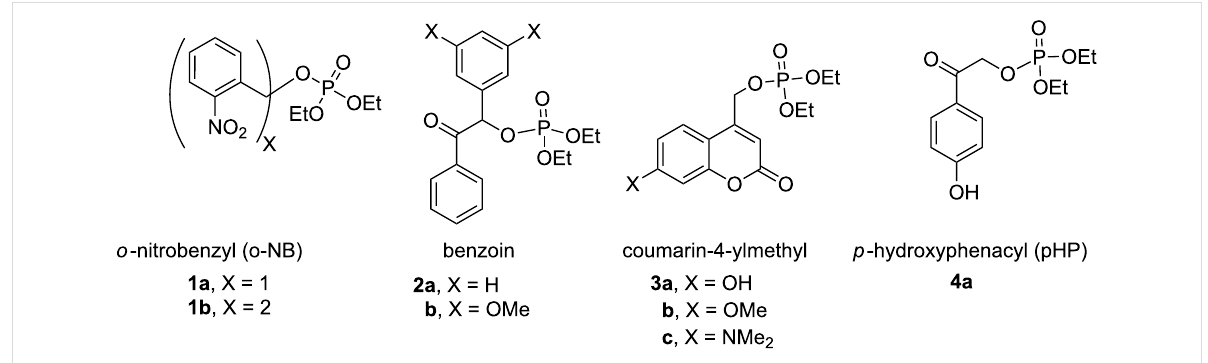
by electron withdrawing, meta substituents is contrary to their ground state effects on solvolysis reactions which, instead, display enhanced reactivity for para substituents. This contrasting substituent reactivity is a consequence of two different potential energy surface (PES) contours that control the reactivity, an observation first rationalized by Zimmerman through a comparison of the change in PES electron distribu- tion in the ground (HOMO) and excited states (LUMO) using Hückel molecular orbital theory [2,3], subsequently attributed by him to the positioning of conical intersections between the HOMO–LUMO PE surfaces [4,5]. He termed this phenomenon the “ meta effect”, and generalized it for photochemical solvol- ysis reactions. Several additional photosolvolysis studies substantiated the generality of the meta effect for phosphate leaving groups in heterolytic